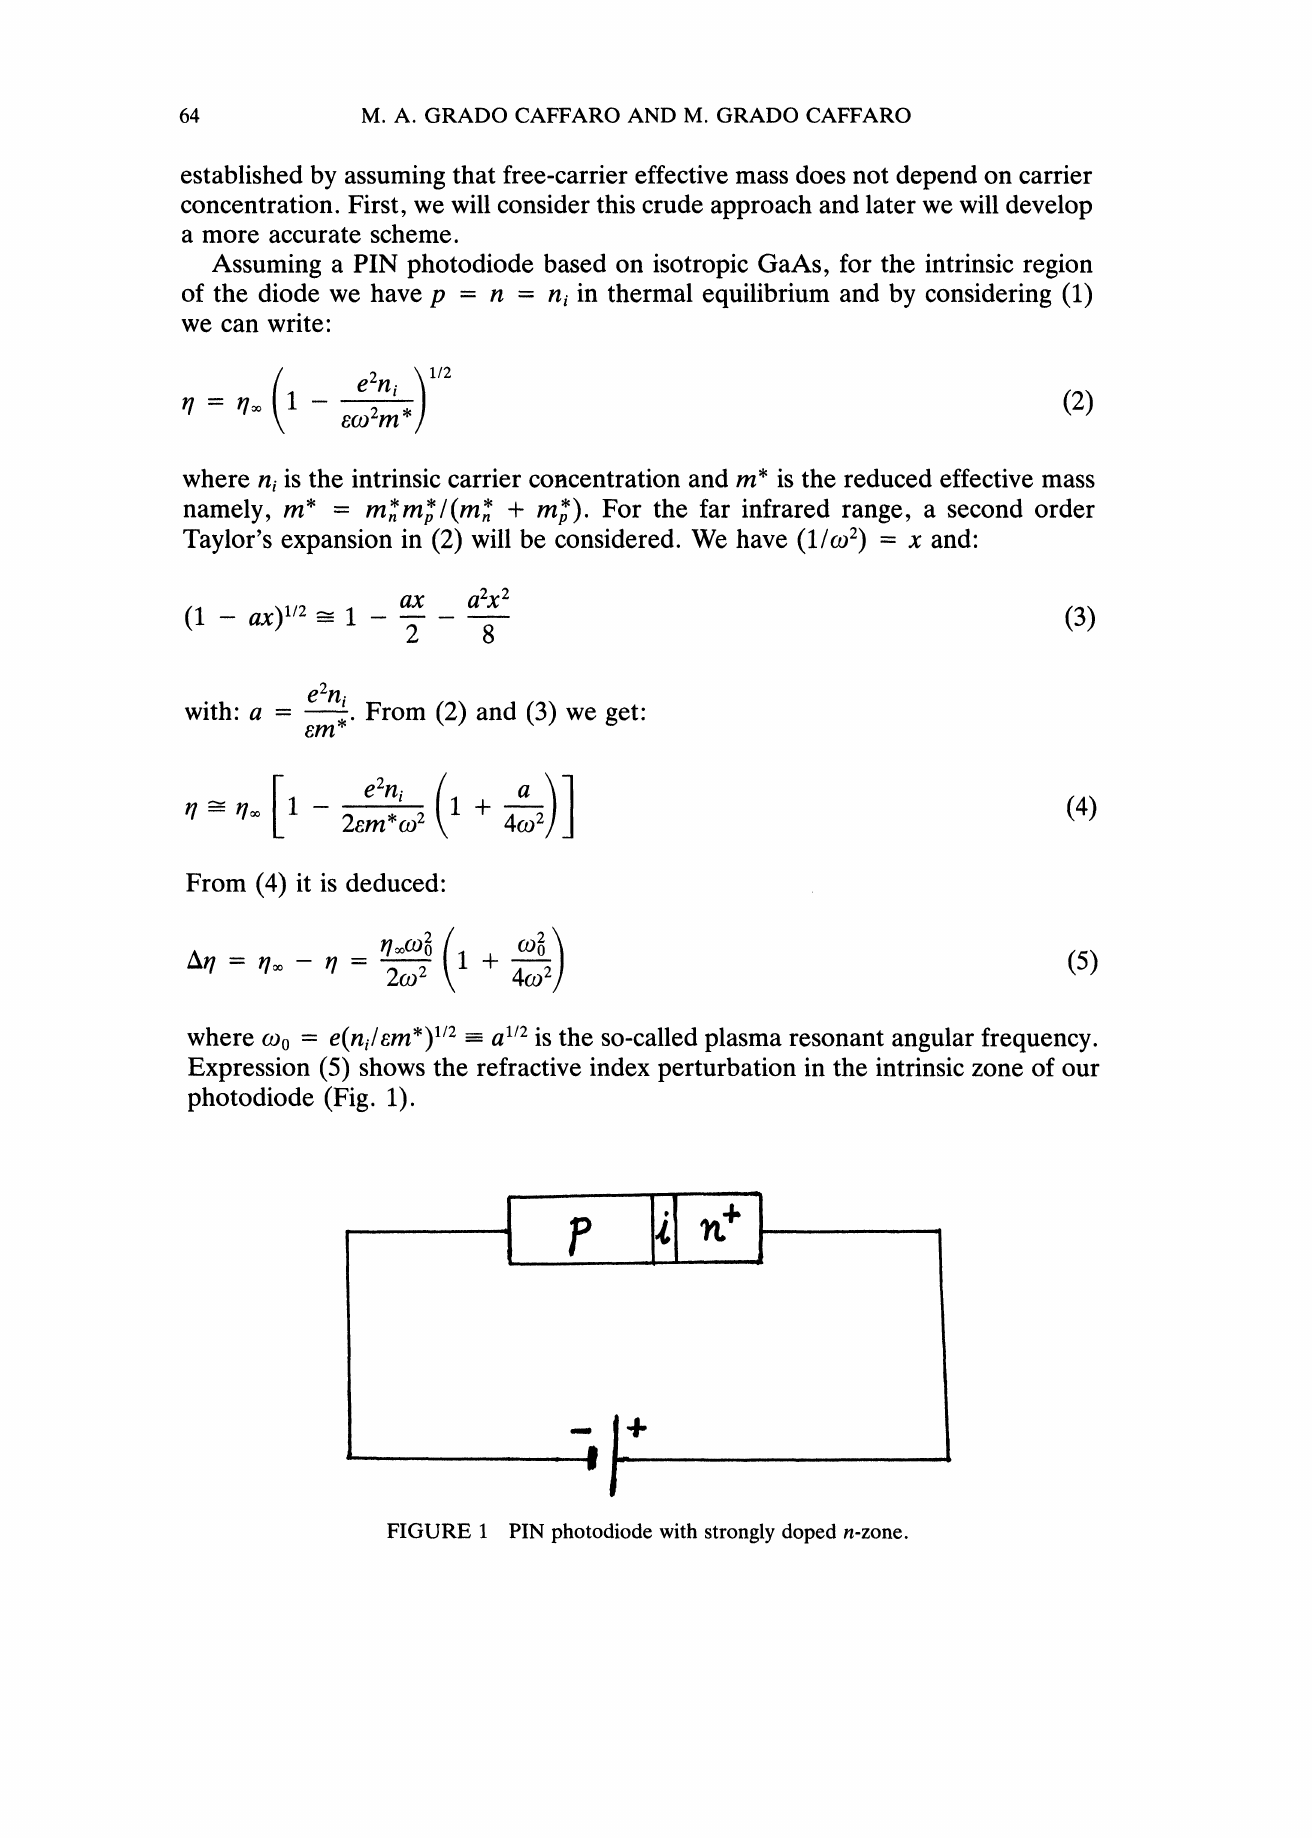
FIGURE 1 PIN photodiode with strongly doped